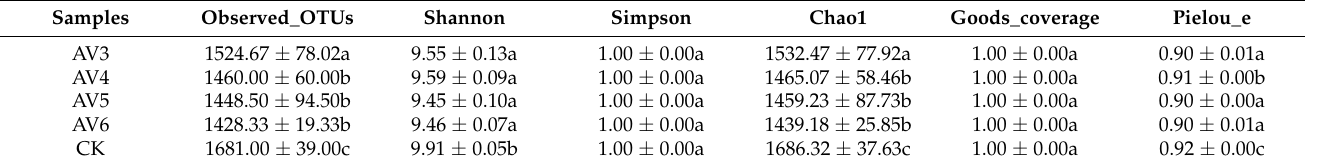
Table 3. Alpha diversity indices of the bacterial community in A. villosum rhizosphere soils and a fallow field.